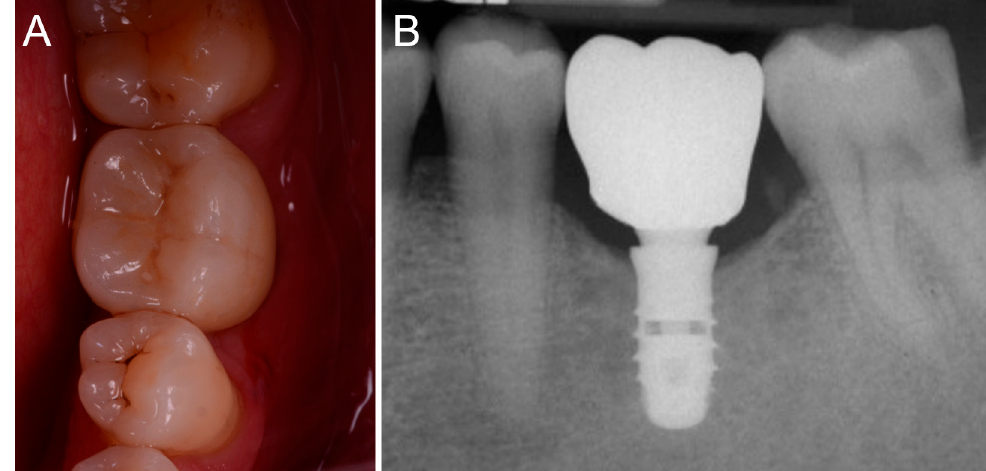
Figure 13. Delivery of the final crown (DONE2). ( A ) clinical view; ( B ) endoral periapical radiograph of the final restoration.